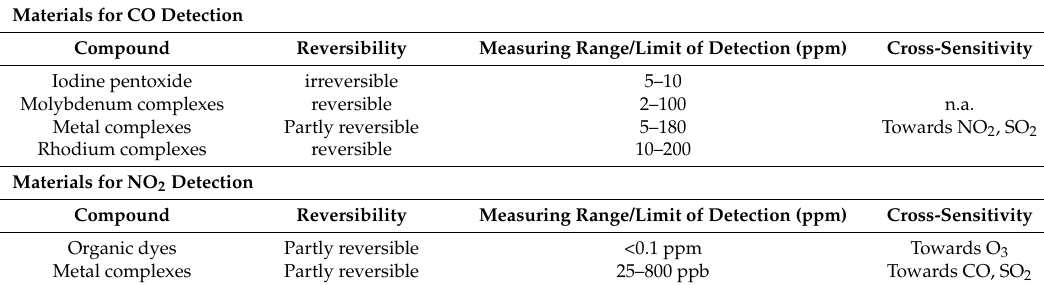
Table 4. Summary of colorimetric compounds suitable for CO and NO 2 detection in fire